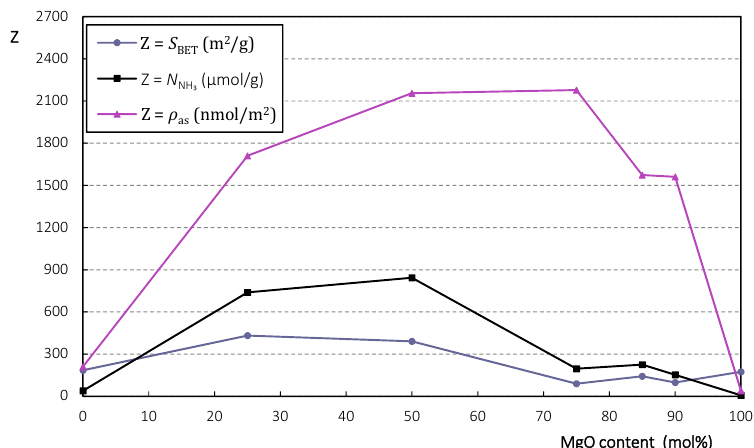
Figure 5. Characterization results of the textural and surface acid investigations on the binary M1/SiO 2 mixed oxides and the precursors M1 and SiO 2 .